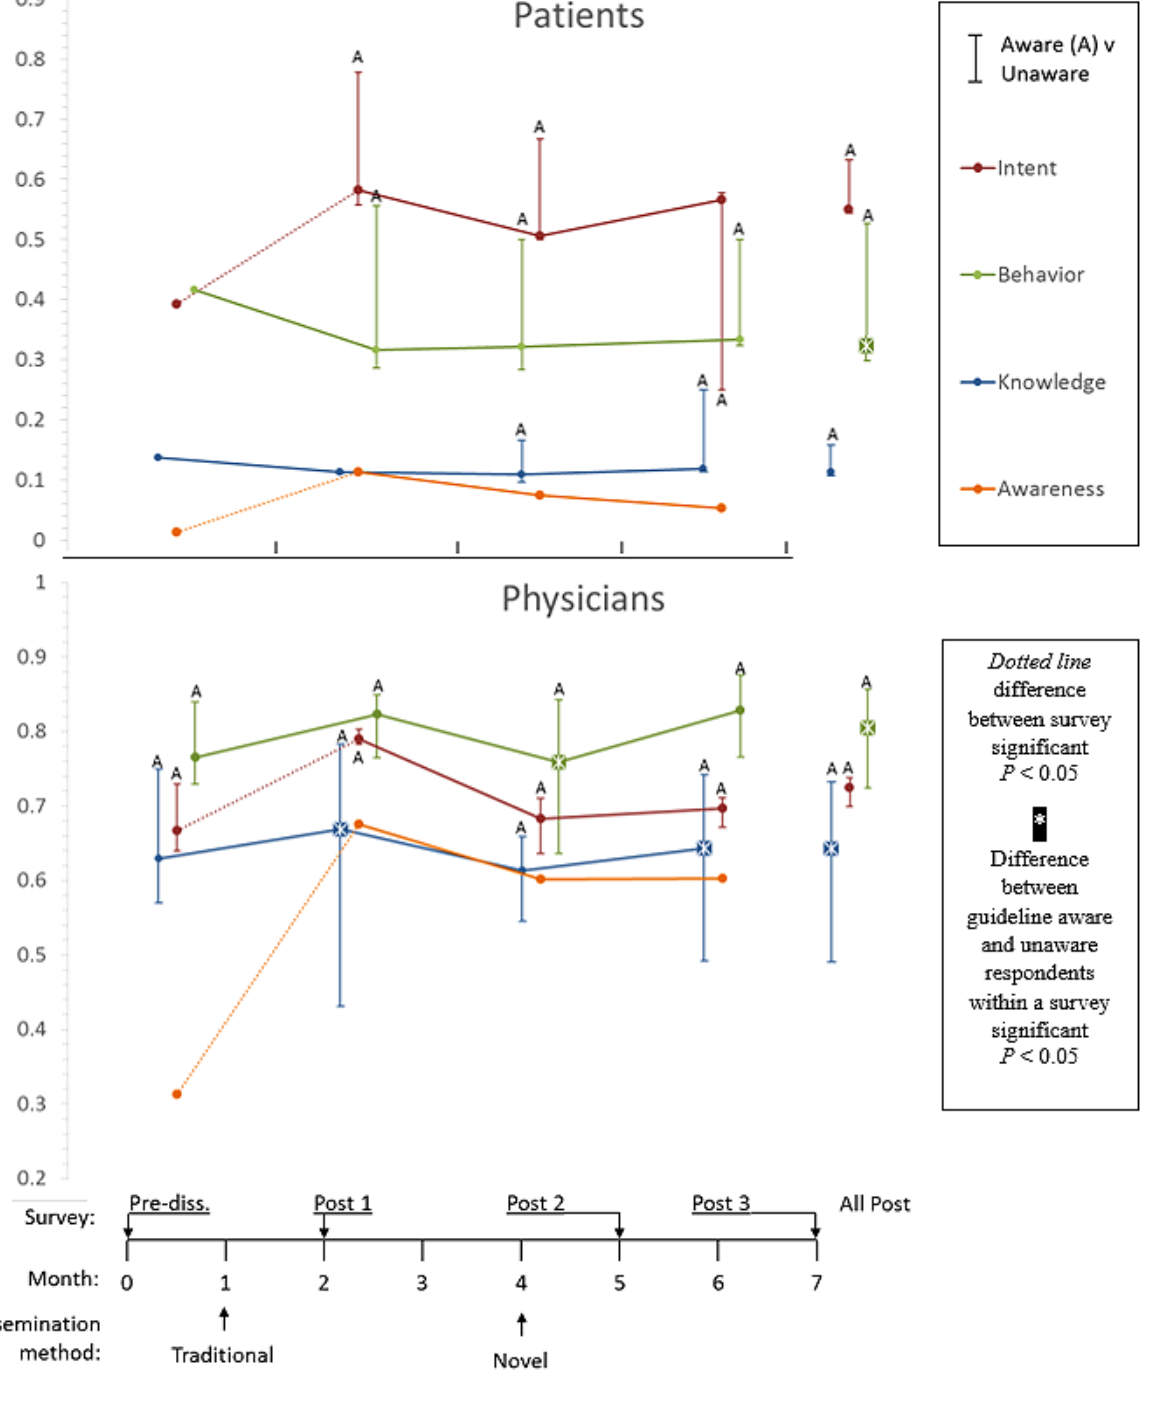
Figure 1. Timeline of dissemination (horizontal axis), CPG awareness, correct CAM knowledge, intent to discuss CAM, and behavior for patients and physicians. Patient results are represented in the upper set of graphs, and physician results in the lower set. The horizontal axis represents time in months and delineates the point of the traditional and novel dissemination efforts and each of the 4 study surveys: pre-dissemination, post-traditional dissemination (post-1), post-novel dissemination (post-2), the results 6 months after traditional dissemination (post-3), and combined results of all post-dissemination surveys. The vertical axis represents the percentage of respondents. The outcome variables (awareness, knowledge, intent, and behavior) are represented by orange, blue, green, and maroon lines, respectively. Dotted lines indicate significant differences between the 2 surveys. The vertical bars represent within-surveys comparison of unaware and aware respondents for each outcome variable. Starred boxes indicate significant